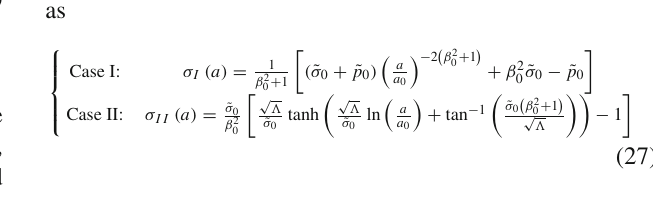
Fig. 4 V II and σ II in terms of a for a 0 = 2 . 5 M , β 2 with Fig. 1 and the potential’s shape changes due to the effects of v 0 (cid:2)= 0 . Such effects are not trivial but